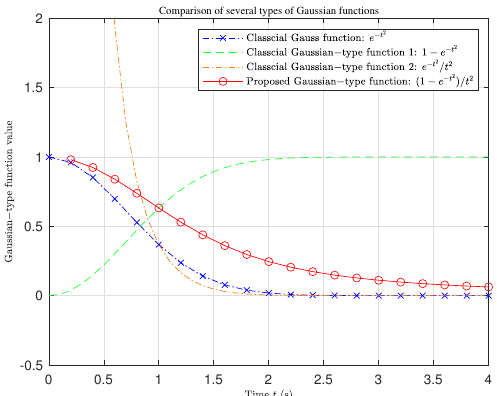
Figure 6. Comparison of four classes of Gaussian-type kernel functions. It can be seen that GKF-QQ has a very high similarity with basic Gaussian function. They both approach 1 near 0, lim t → 0 e − t 2 = 1 and lim t → 0 ( 1 − e − t 2 ) / t 2 = 1; As time approaches infinity, they both approach 0, lim t → ∞ e − t 2 = 0 and lim t → ∞ ( 1 − e − t 2 ) / t 2 =